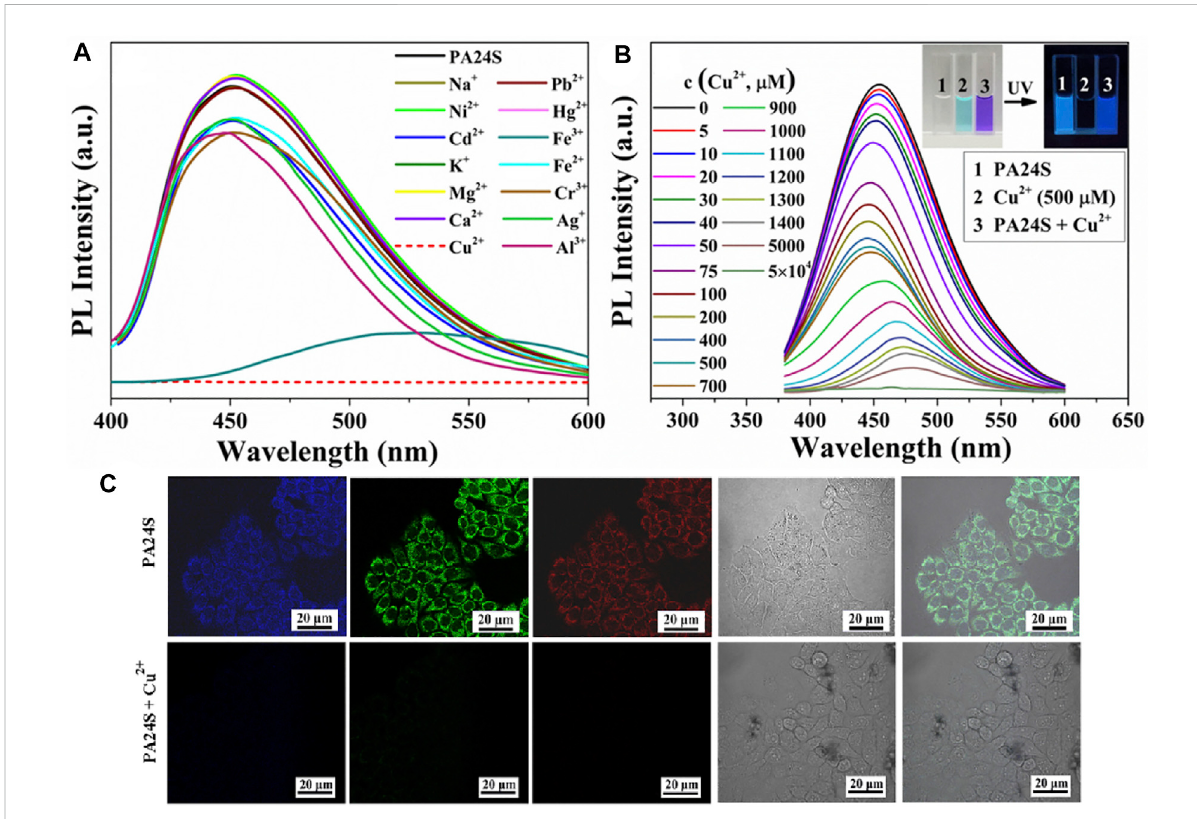
FIGURE 7 (A) Fluorescence emission spectra ( λ Ex = 370 nm) of PA24S solution in the presence of different metal ions; (B) those of PA24S solution as a function of Cu 2+ concentration; (C) images of CFM of HeLa cells cultured for 30 min in the presence of PA24S and Cu 2+ under 405 nm, 488 nm, 561 nm, bright fi eld, and their overlay (Wang Q. et al.,